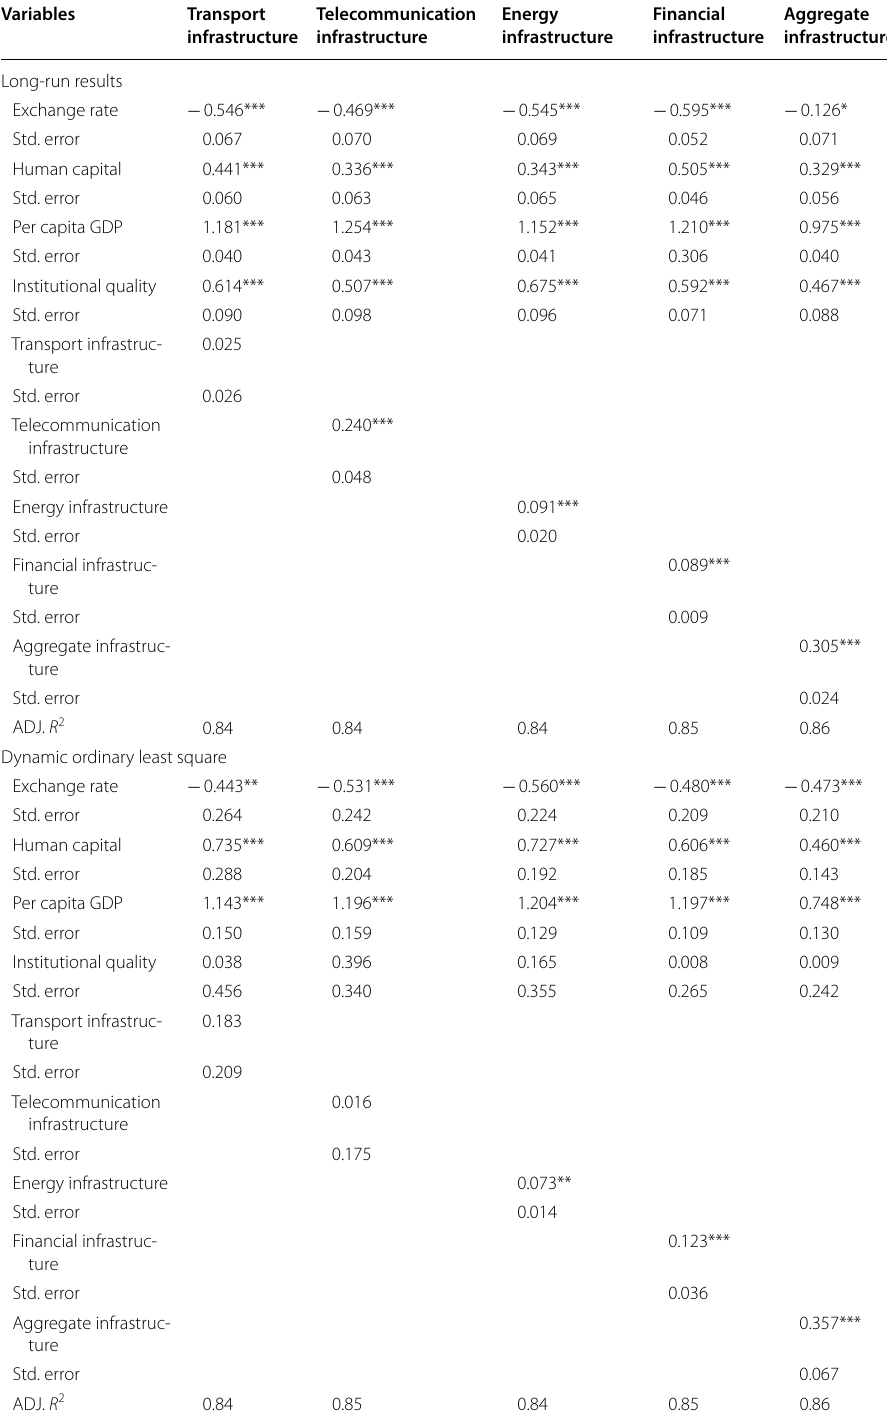
Table 7 Fully modified OLS results (export is dependent